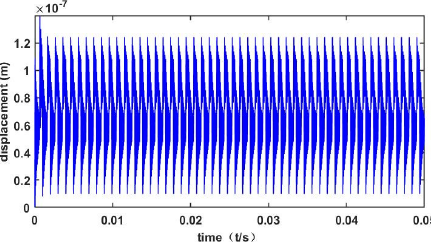
Figure 10. Time domain diagram of fault-free vibration.